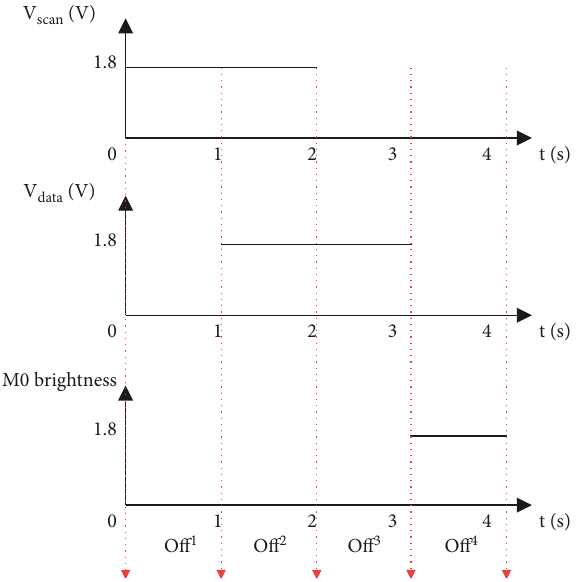
Figure 2: Timing diagram of the pixel drive